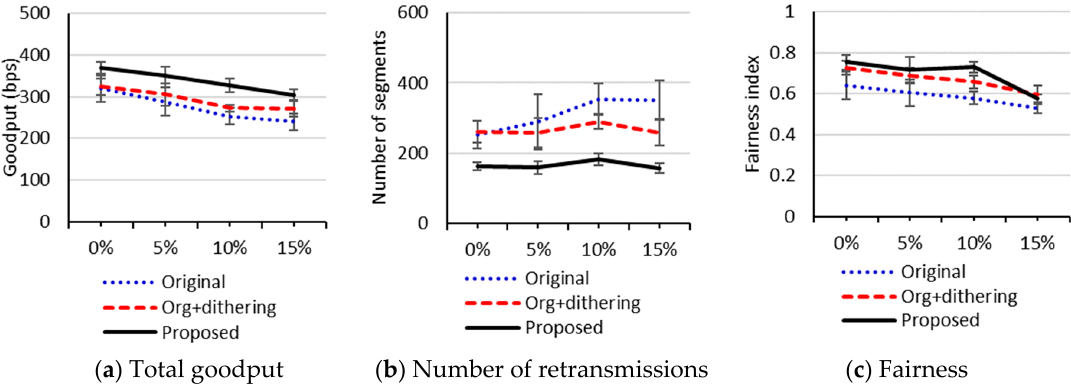
Figure 8. Performance with respect to random loss rates in a 4 × 4 grid topology network when ContikiMAC is used.